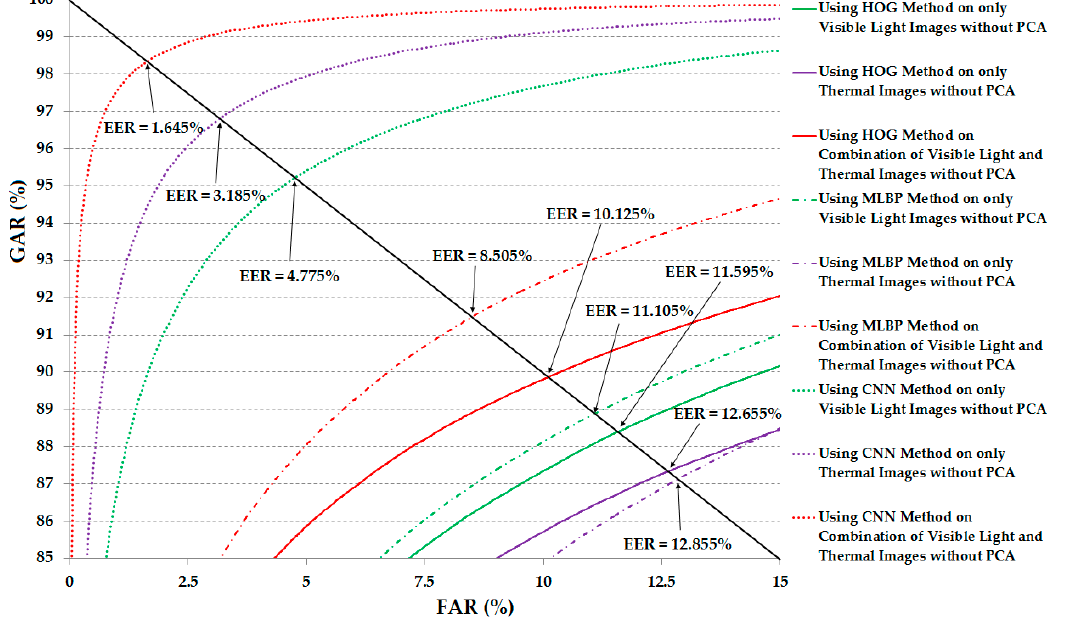
Figure 13. ROC curves of the verification systems (system that uses only visible light, only thermal, and a combination of visible light and thermal images for verification) using correlation distance without applying PCA.